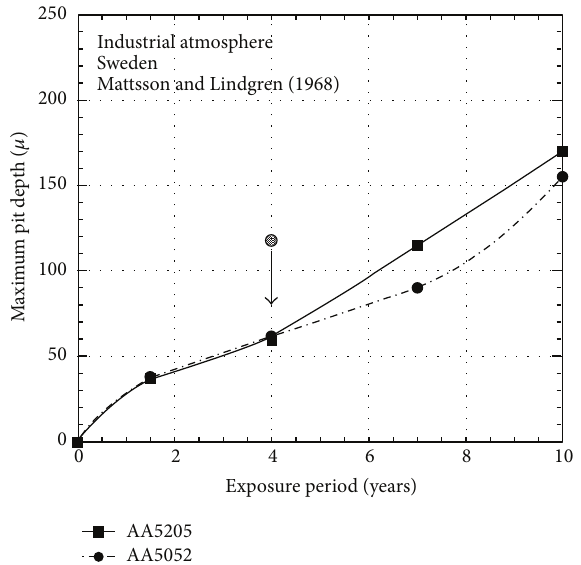
Figure 4: Data for maximum pit depth of aluminium alloys AA5205 and AA5052 exposed in an industrial atmospheric environment showing the trends for pit depth are bimodal. In this case the changeover to mode2 occurs at about 5 years of exposure. Data from Mattsson and Lindgren [13].